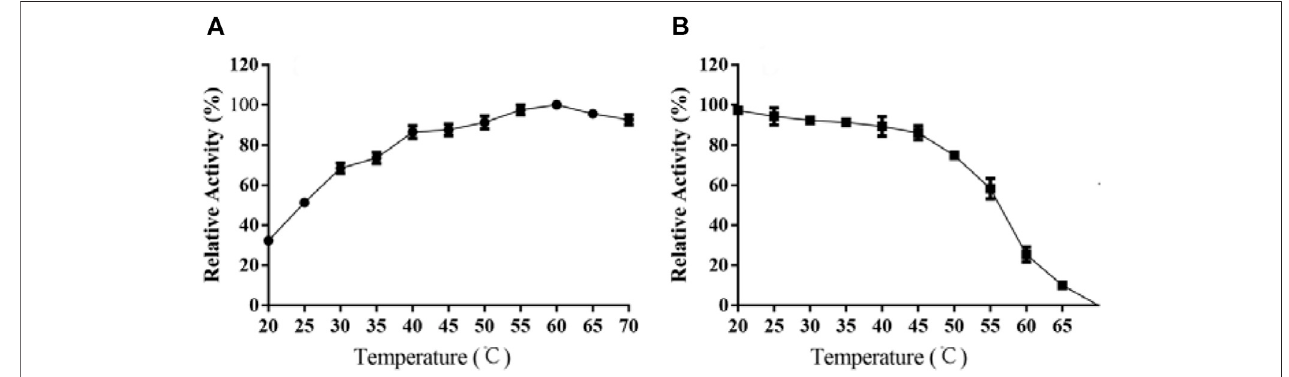
FIGURE 4 | Effects of temperature on the activity (A) and stability (B) of TanA. (A) The optimal temperature of TanA was assessed in the range of 20 – 70 ° C, regarding the activity at optimum temperature as 100%. (B) The temperature stability of TanA was determined by measuring the residual activity after incubation under 20 – 70 ° C for 12 h; the initial activity was taken as 100%.